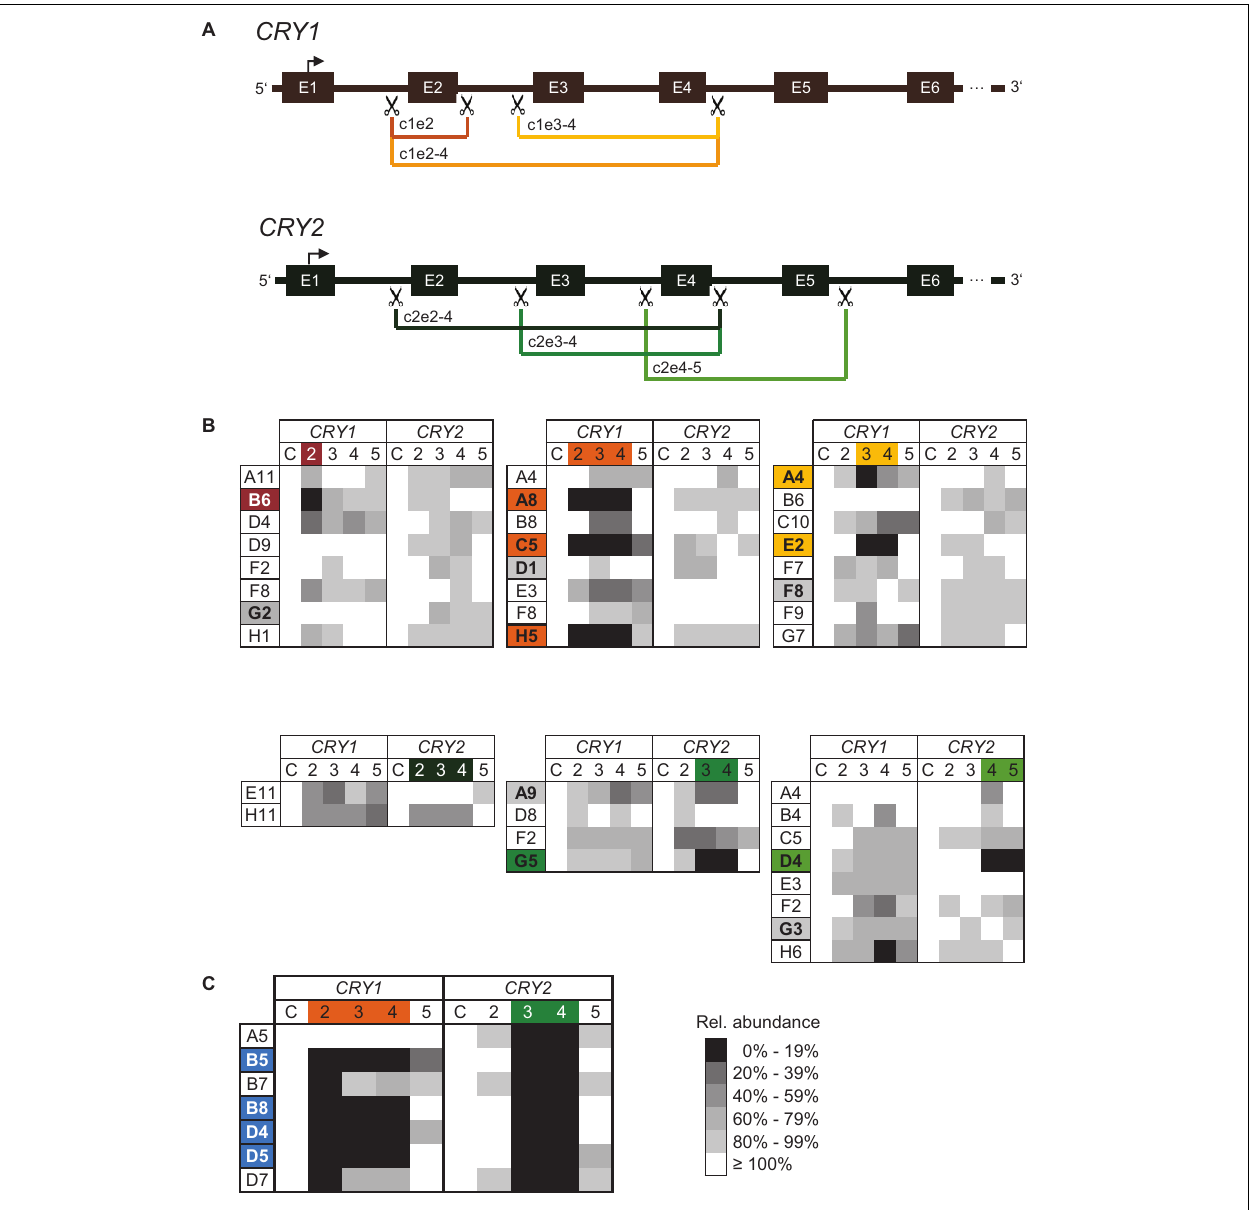
FIGURE 2 | CRISPR/Cas9-mediated generation of CRY1 and CRY2 knockout cells (A) Schematic overview of CRISPR/Cas9-mediated exon deletion strategy. SgRNAs were designed to introduce a double strand break in intron regions upstream and downstream of target exons (scissors). Deletion of target exons induces a frameshift resulting in a premature STOP codon. For each CRY gene three (out of six) different guide RNA combinations are exemplarily shown in different colors. E.g., c1e2-4 refers to a sgRNA combination that aimed at the deletion of exons 2 to 4 of CRY1 . E: exon. (B) Relative genomic abundance of targeted exons in single cell clones. Cell populations as indicated in Supplementary Figure 1 were sub-cloned, and genomic DNA of individual clones was analyzed for exon deletions using qPCR. As control C, abundance of 3 (cid:48) -UTR regions of each gene were quantified. Single cell clones with undetectable levels of targeted exons were maintained for further analysis (marked in the corresponding color), single cell clones with minimal reduction in all screened genomic loci were maintained as controls (marked in gray). (C) Generation of CRY1 / CRY2 double knockout cells. The CRY2 knockout cell clone G5 [see (A) ], was transduced with Cas9 and sgRNA expression vector targeting exons 2–4 of CRY1 . Single cell clones were analyzed for genomic deletion of target exons as described above. Shown are results for six clones, four of which were selected for further downstream analysis.